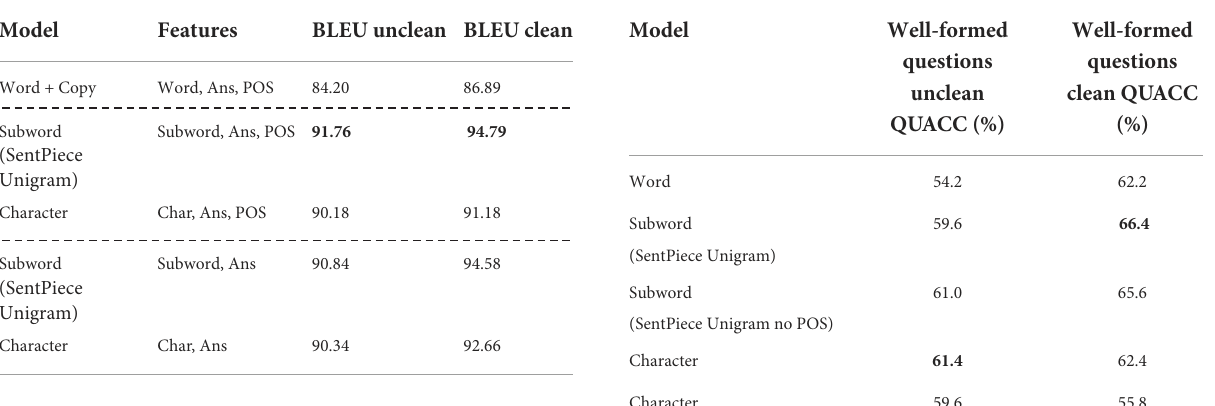
TABLE 2 Quantitative evaluation results. TABLE 3 Results per question for the evaluation set of 500 QA